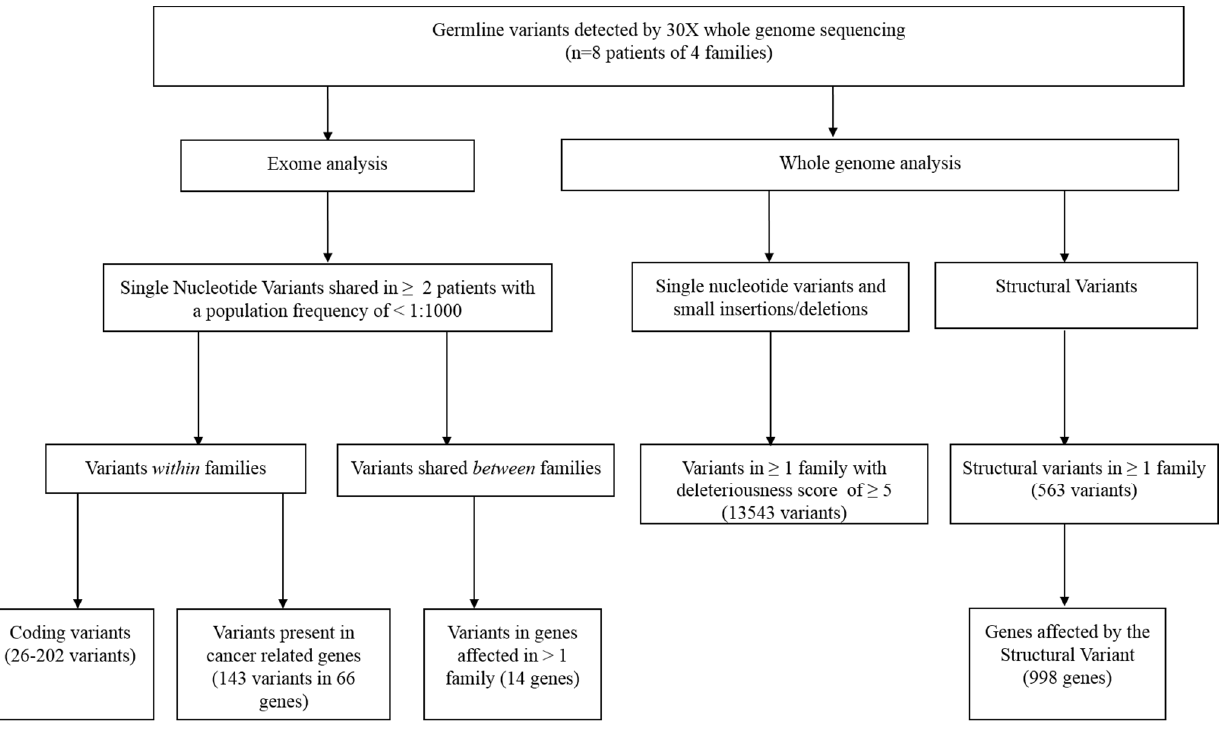
Figure 2. Filter approach. Figure 2. Filter Table 2. Detected overlapping germline variants per family.